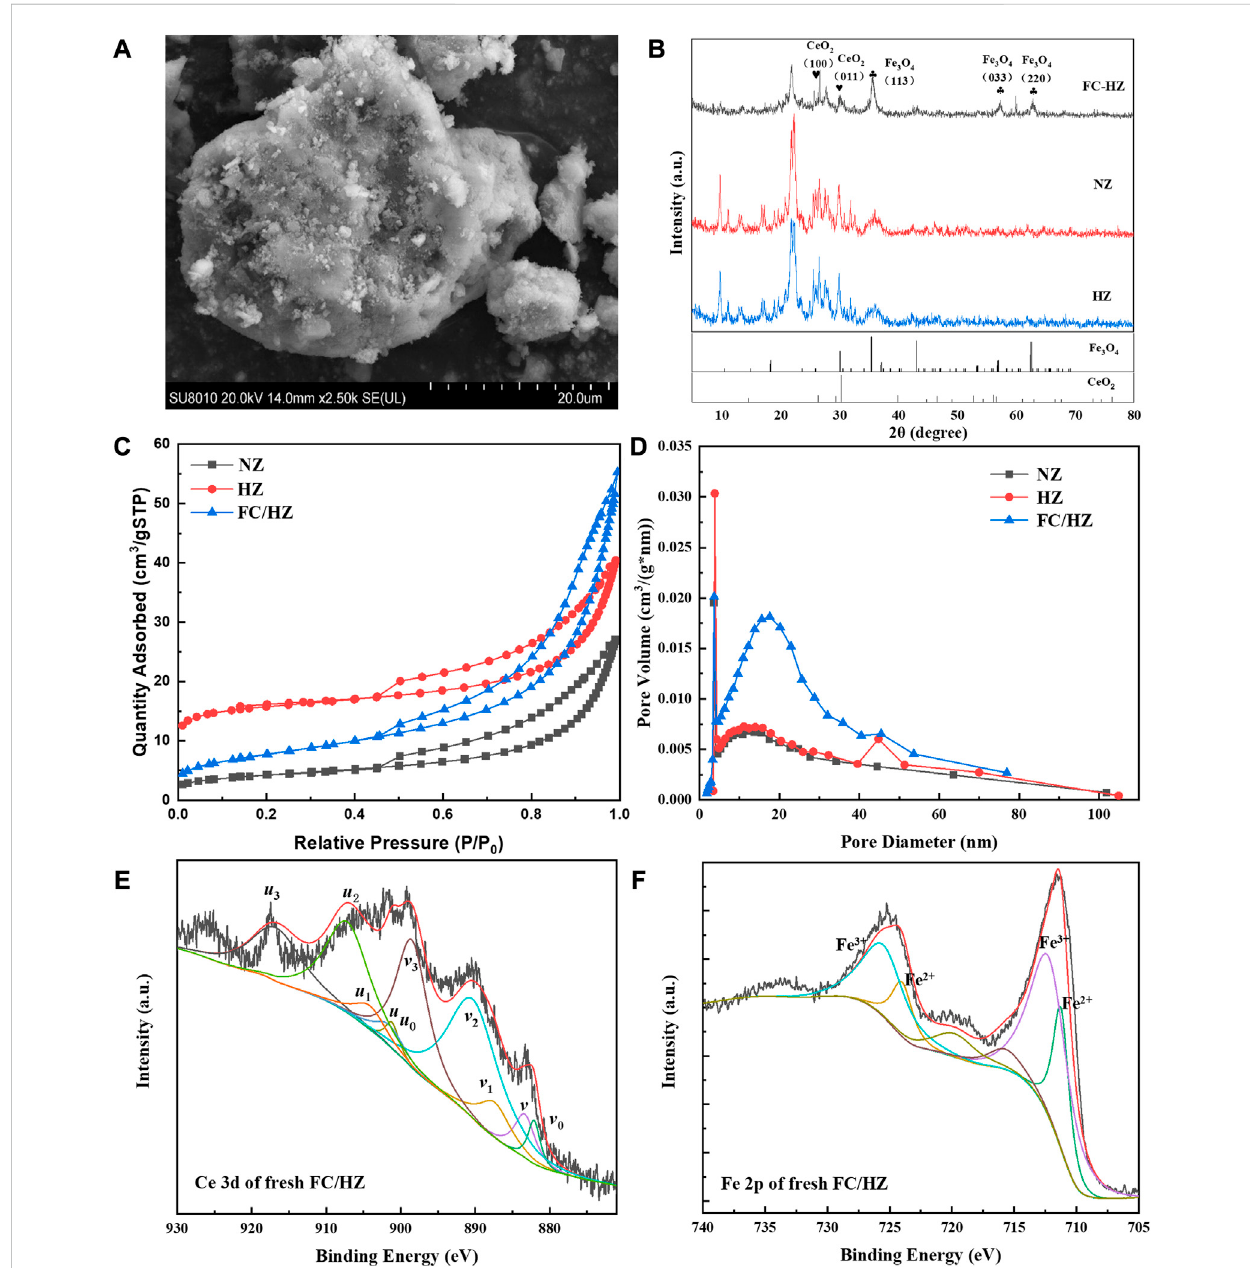
FIGURE 1 Morphologies, crystalline structures, pore size distribution, and chemical states of the FC/HZ catalyst. (A) SEM image. (B) XRD spectra. (C) and (D) show BET data. (E) and (F) show the spectrum of Ce 3d and Fe